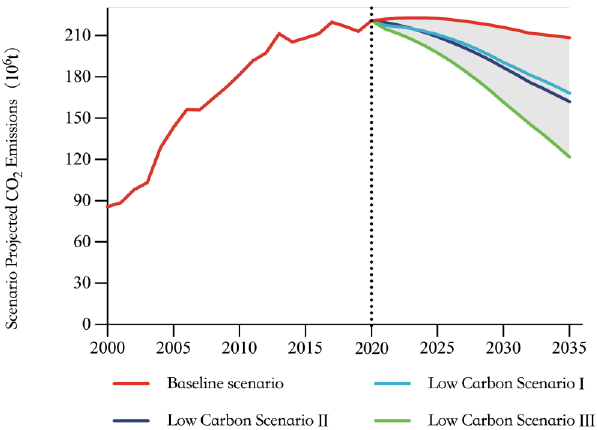
Figure 7. Prediction of CO 2 emissions from life cycle of paper products under the low carbon sce- nario.